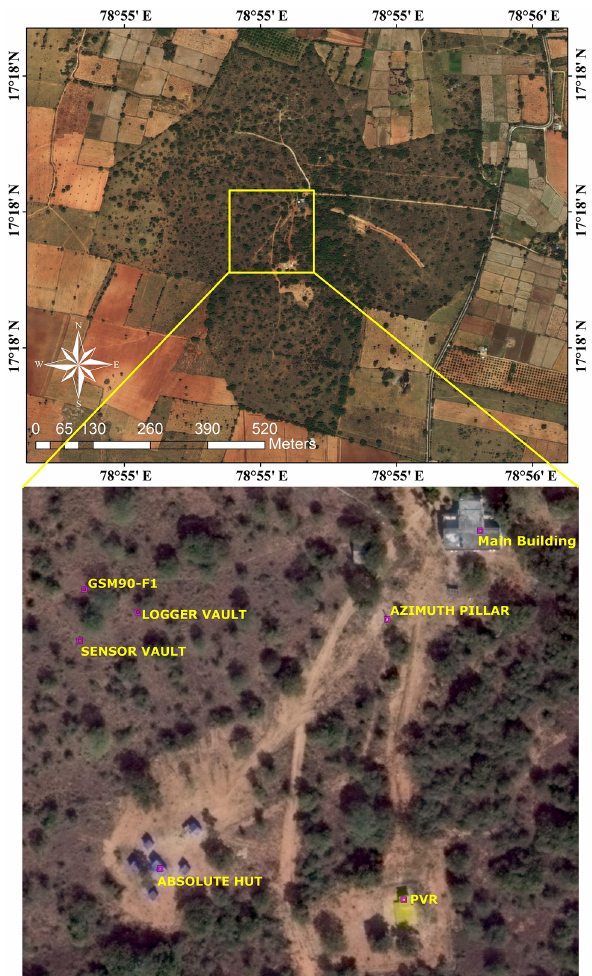
Figure 1. Overview of the Choutuppal campus of the CSIR- National Geophysical Research Institute (top panel); the high- lighted text shows the location of the variometer vaults, azimuth pillar, absolute hut and primary variometer room (PVR) of the Choutuppal magnetic observatory (bottom panel).